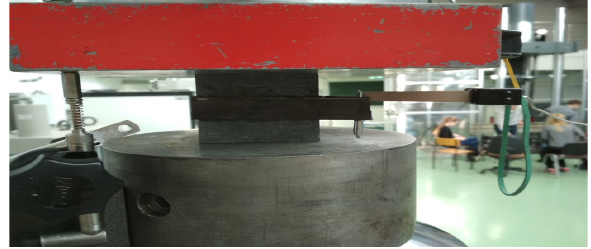
Figure 4: Compression with extensometer test.